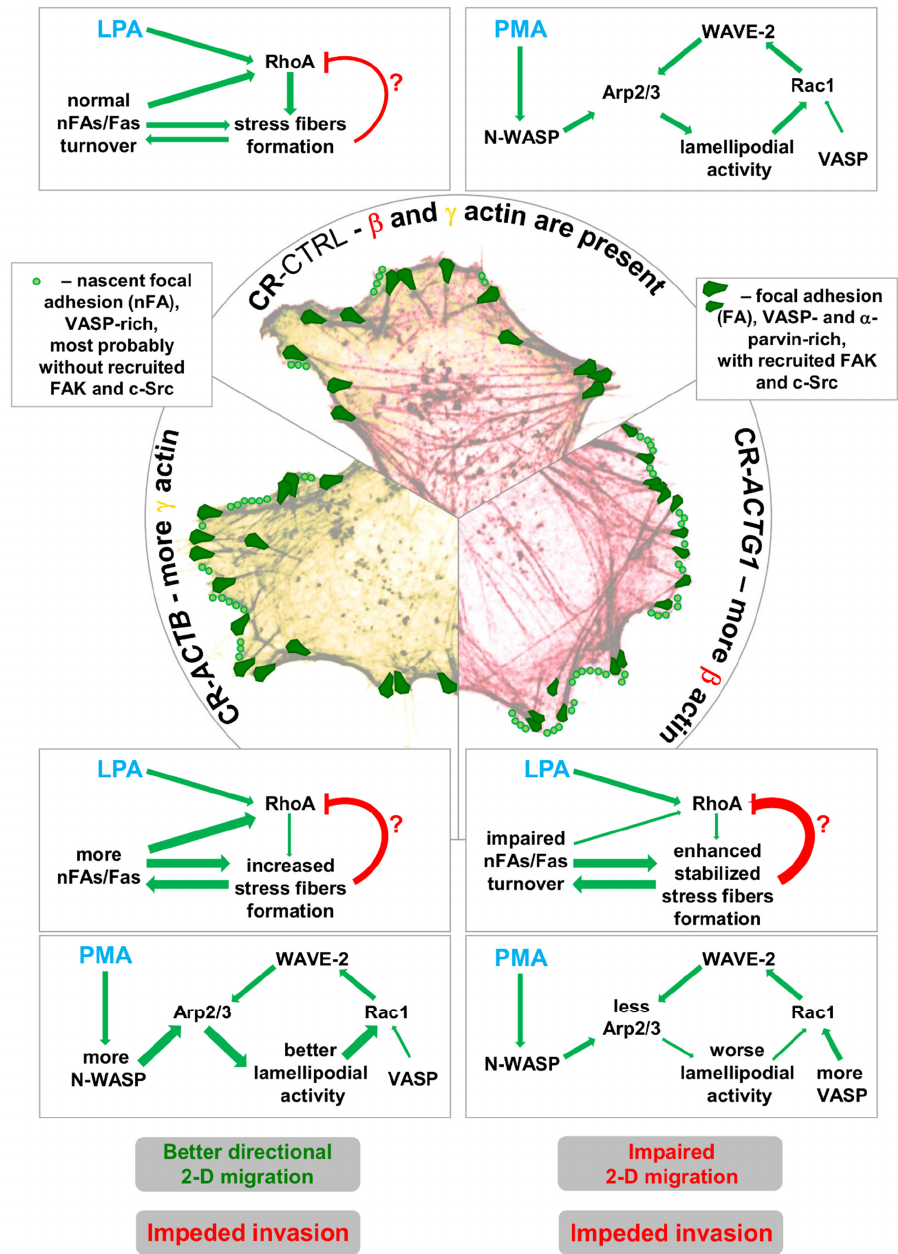
Figure10. ProposedmechanismofinfluenceofdisturbedactinorganizationinCR- ACTB andCR- ACTG1 cells on melanoma cells’ motility and adhesion. Cells devoid of β actin that grew in full medium exhibited more nascent (VASP-rich) focal adhesions (nFAs) and mature (VASP- and α -parvin-rich) focal adhesions (FAs) than did CR-CTRL cells. Although the CR- ACTG1 and CR- ACTB cells possess more mature FAs under the same conditions than control cells, FAs of CR- ACTG1 cells are smaller. Moreover, CR- ACTG1 cells have many more nascent FAs than both control and CR- ACTB cells. Alterations in FA dynamics, stress fiber formation, and the distribution of some ABPs at the leading edge results in changes in Rac1 activation, improved 2-D migration, and impaired invasion in CR- ACTB cells. In the case of CR- ACTG1 cells, the impaired FA turnover, increased number of thick stress fibers, and decreased level of Arp3 at the leading edge led to lowered activation status of RhoA and finally to impeded 2-D and 3-D migration. For details, please see the discussion. In summary, the lack of γ actin has more severe e ff ects on melanoma cells than the lack of β actin. We believe that changes in the formation / turnover of FAs might be caused by the di ff erent properties of non-muscle actins’ interactions with